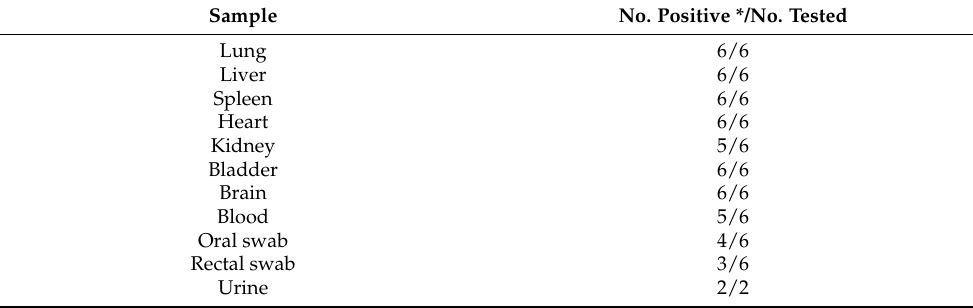
Table 1. Qualitative molecular analysis of tissues collected at 10 days post-infection from laboratory- reared Mastomys natalensis with Lassa